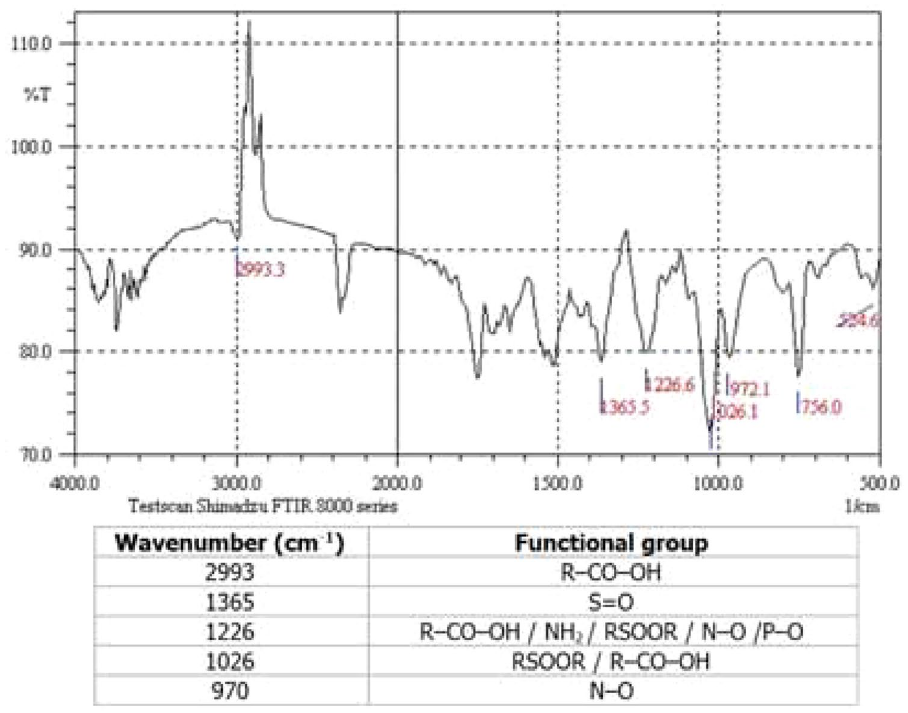
Figure 2. FTIR analysis of crude oil.